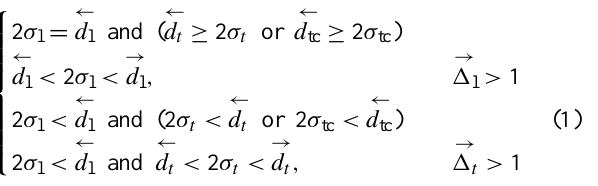
Figure 1 exemplifies spatial and thermal discontinuity ac- cording to Eq. (1) and shows the subsequent adjustment